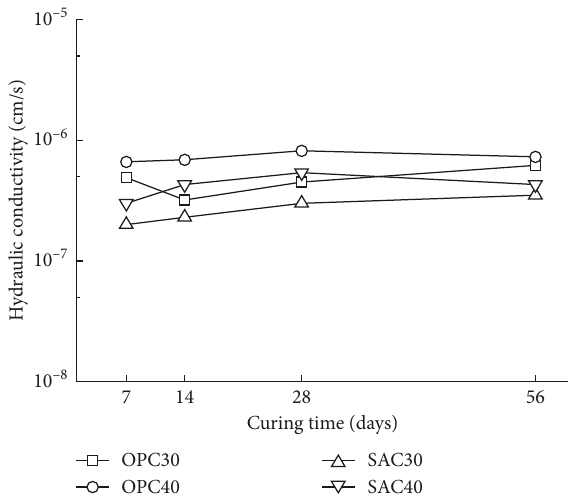
Figure 2: Effect of curing time on hydraulic conductivity of solidified sludge.